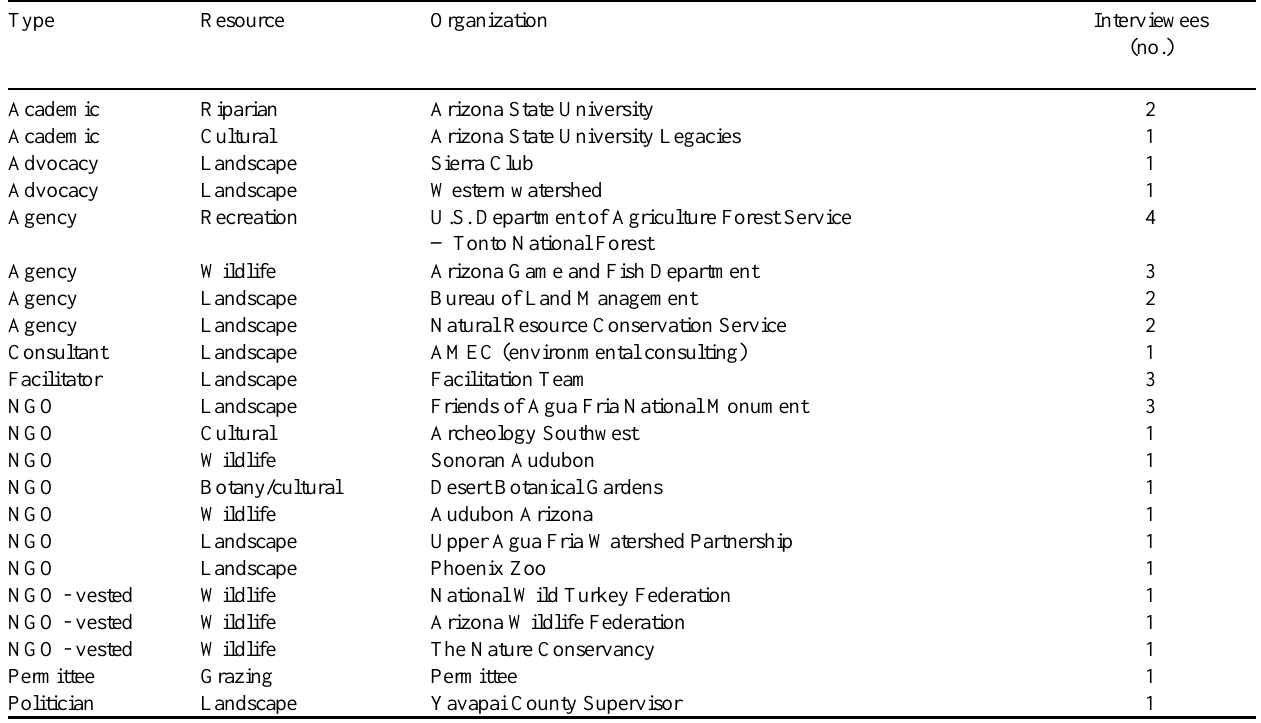
Table 1 . Stakeholder analysis: